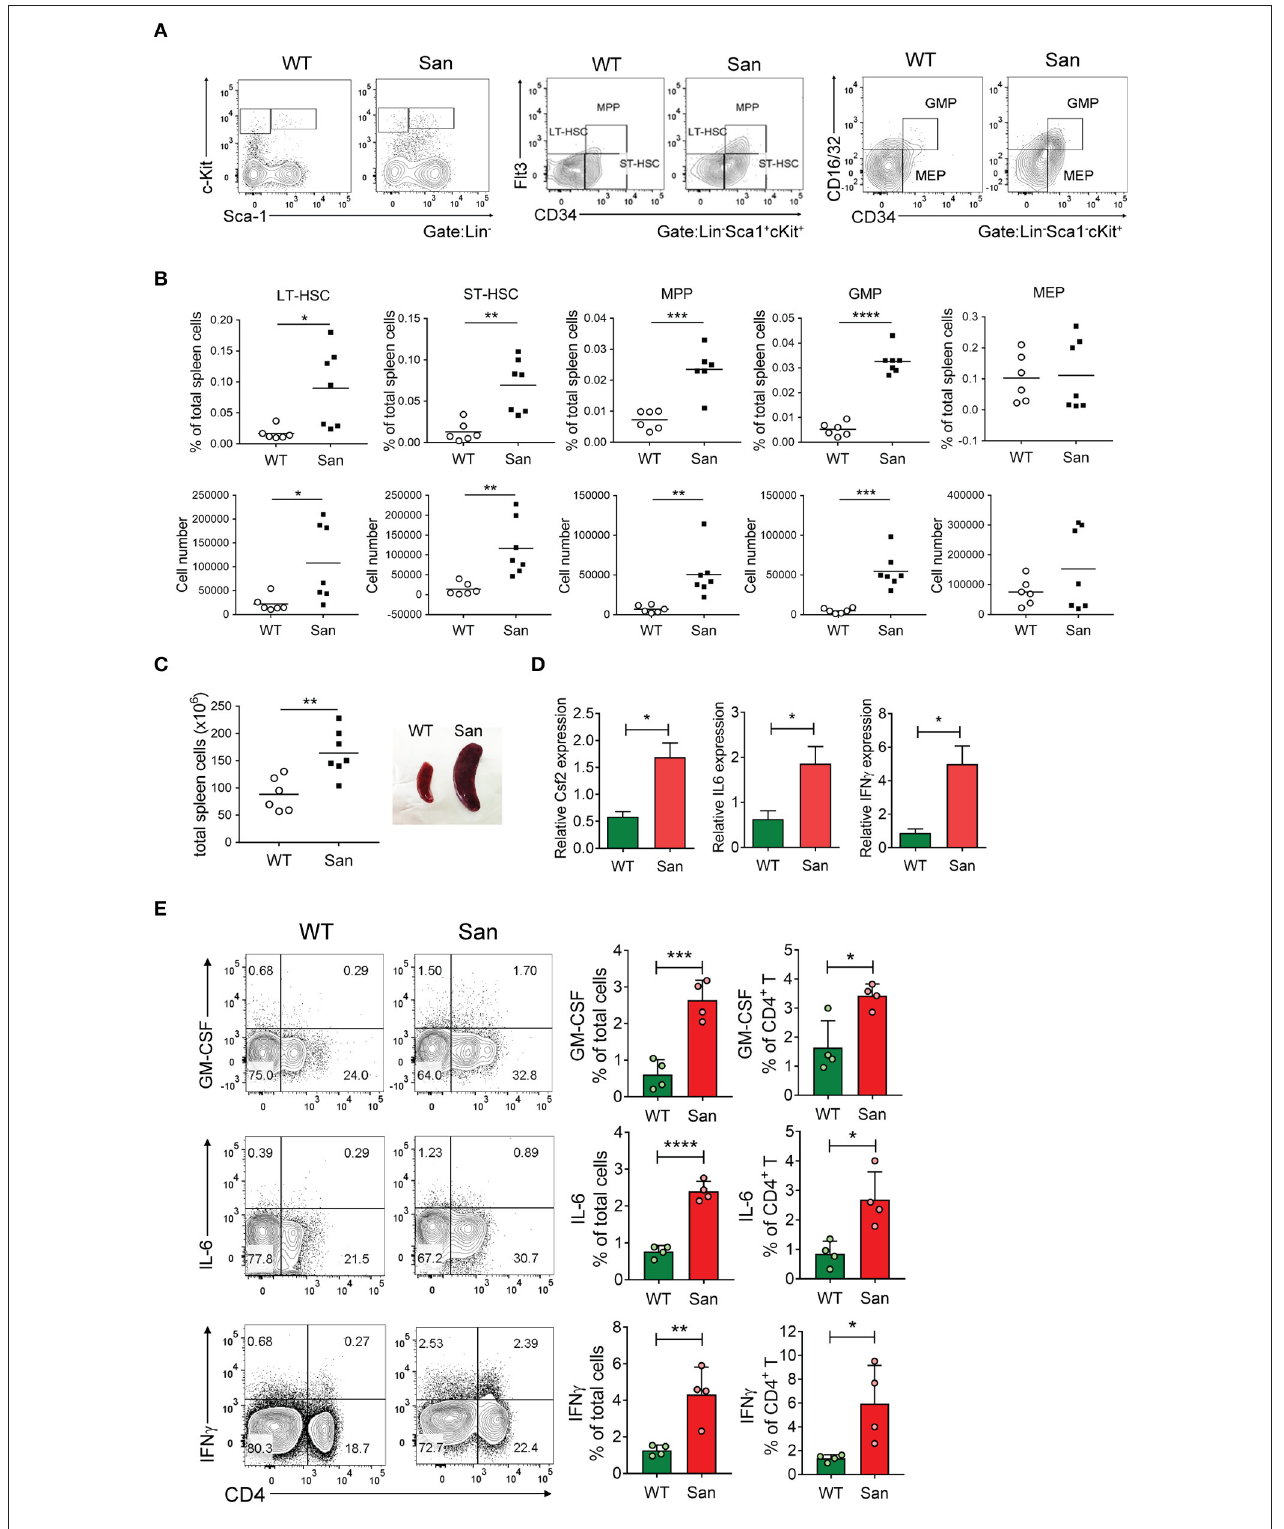
FIGURE 3 | Splenic extramedullary development of SDMCs in sanroque mice. (A,B) Spleen cells from sanroque mice and their WT littermates were assayed by FACS. Representative FACS profiles (A) and percentages and numbers of the indicated cell populations with symbols representing the values of individual mice and horizontal bars representing means (B) are shown. (C) Numbers of total spleen cells and a representative photograph displaying spleens from WT and sanroque mice